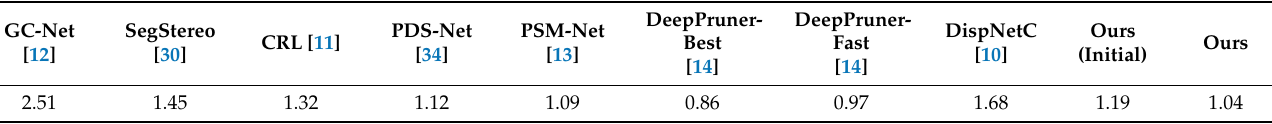
Figure 4. Comparisons of disparity maps on the Scene Flow test set. Table 2. Quantitative comparison results on the Scene Flow test